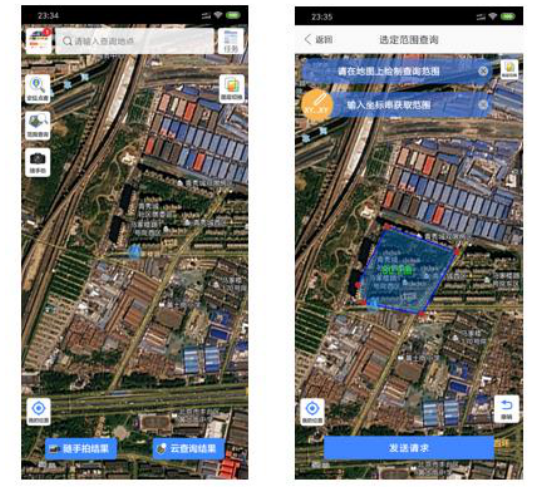
Figure13 .Land Resource Investigation based on multi- temporal image